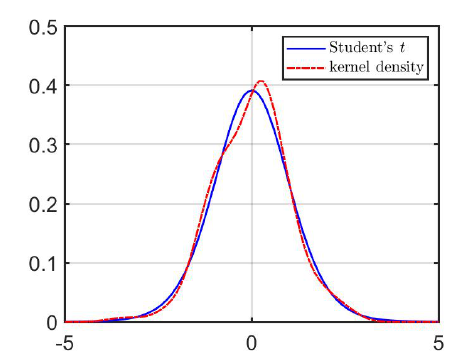
Figure 7. Comparison of the standardized Student’s t -distribution with ν = 13 compared to the empirical distribution of (cid:101) k computed from